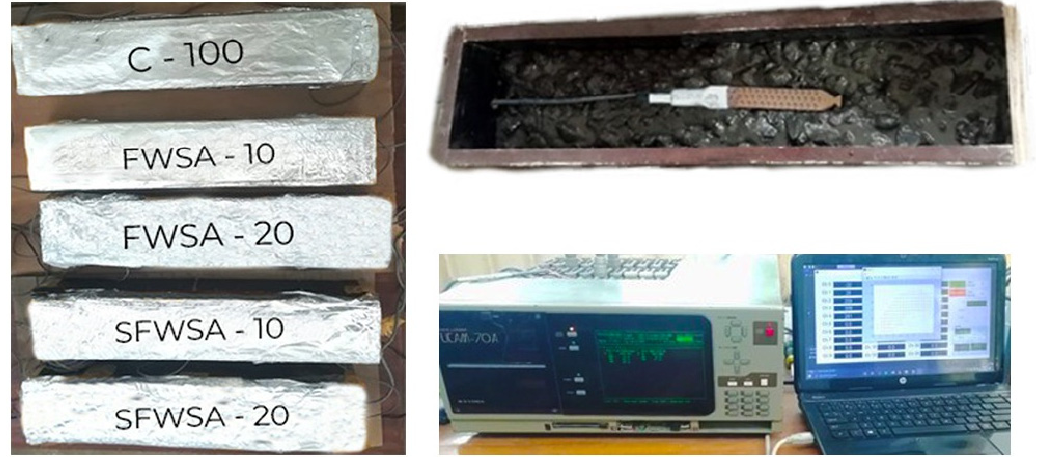
Figure 5. Experimental setup used for measurement of autogenous shrinkage of concrete beams.